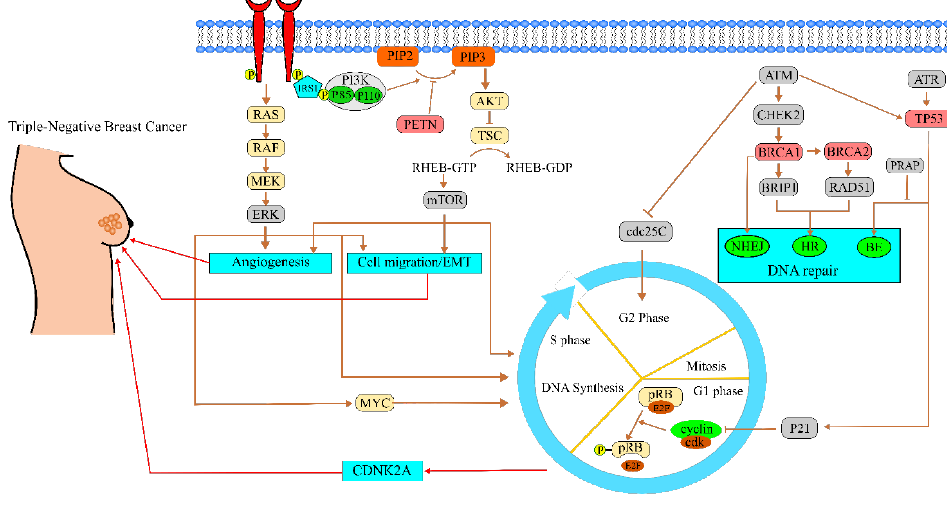
Figure 1. Pathogenesis of